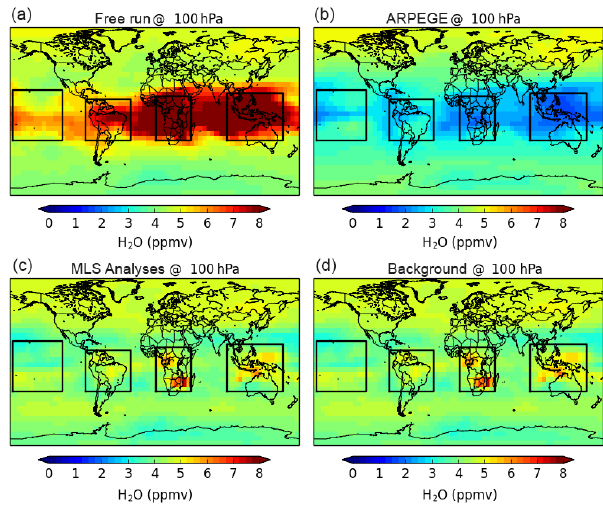
Figure 11. Monthly averaged H 2 O fields at 100hPa in January 2012 in the model space (in the model grid and time samplings) from the free run (MOCAGE, a ), ARPEGE (b) , MLS analyses (assimila- tion, c ) and the background (d) .